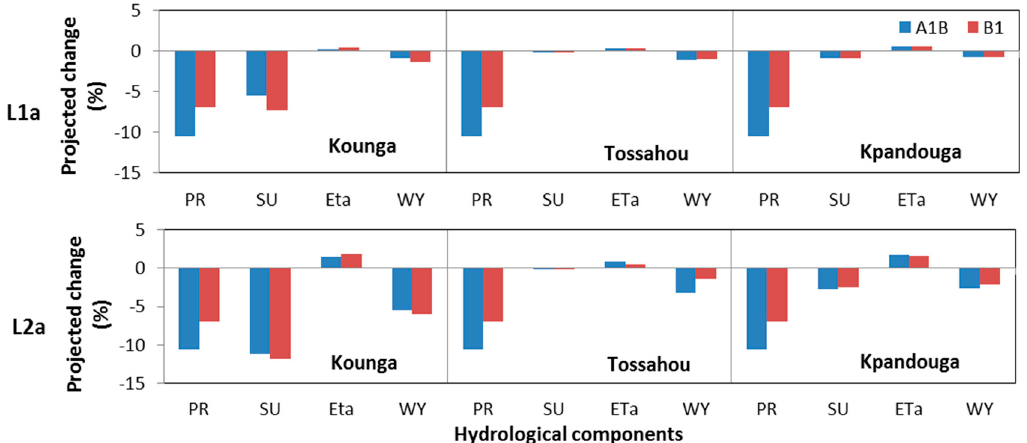
Figure 8. Relative changes induced by the application of fertilizers at the current cultivation system under land use and climate change scenarios from 2030 to 2049. L1a and L2a are land use change scenarios of 25% and 75% lowland conversion under traditional rice cultivation system with fertilizer application, respectively. A1B and B1 are climate change scenarios; ETa is actual evapotranspiration; PR is precipitation; SU is surface runoff; and WY is total water yield.